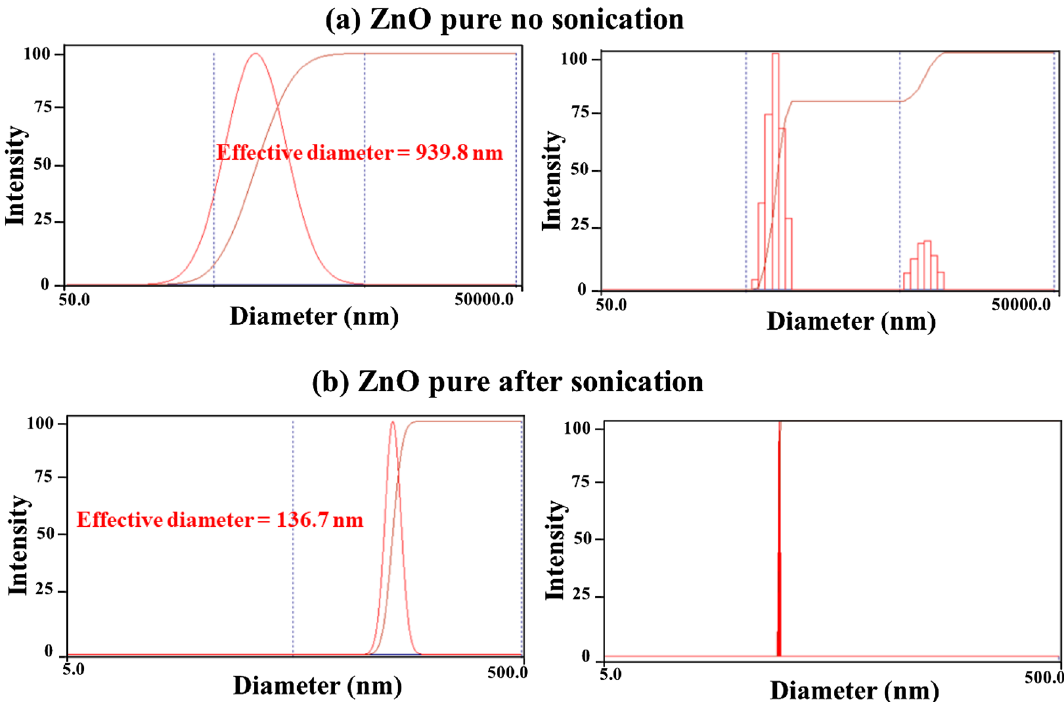
Figure 4. Results of the particle size distribution measurements for the pure ZnO powder without and after